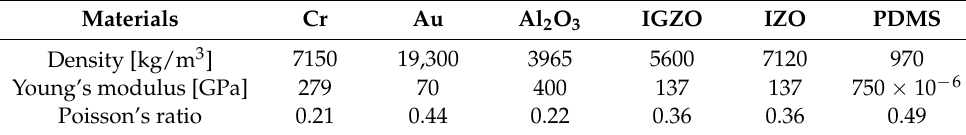
Table 1. Material properties of stretchable a -IGZO TFTs for the FEA